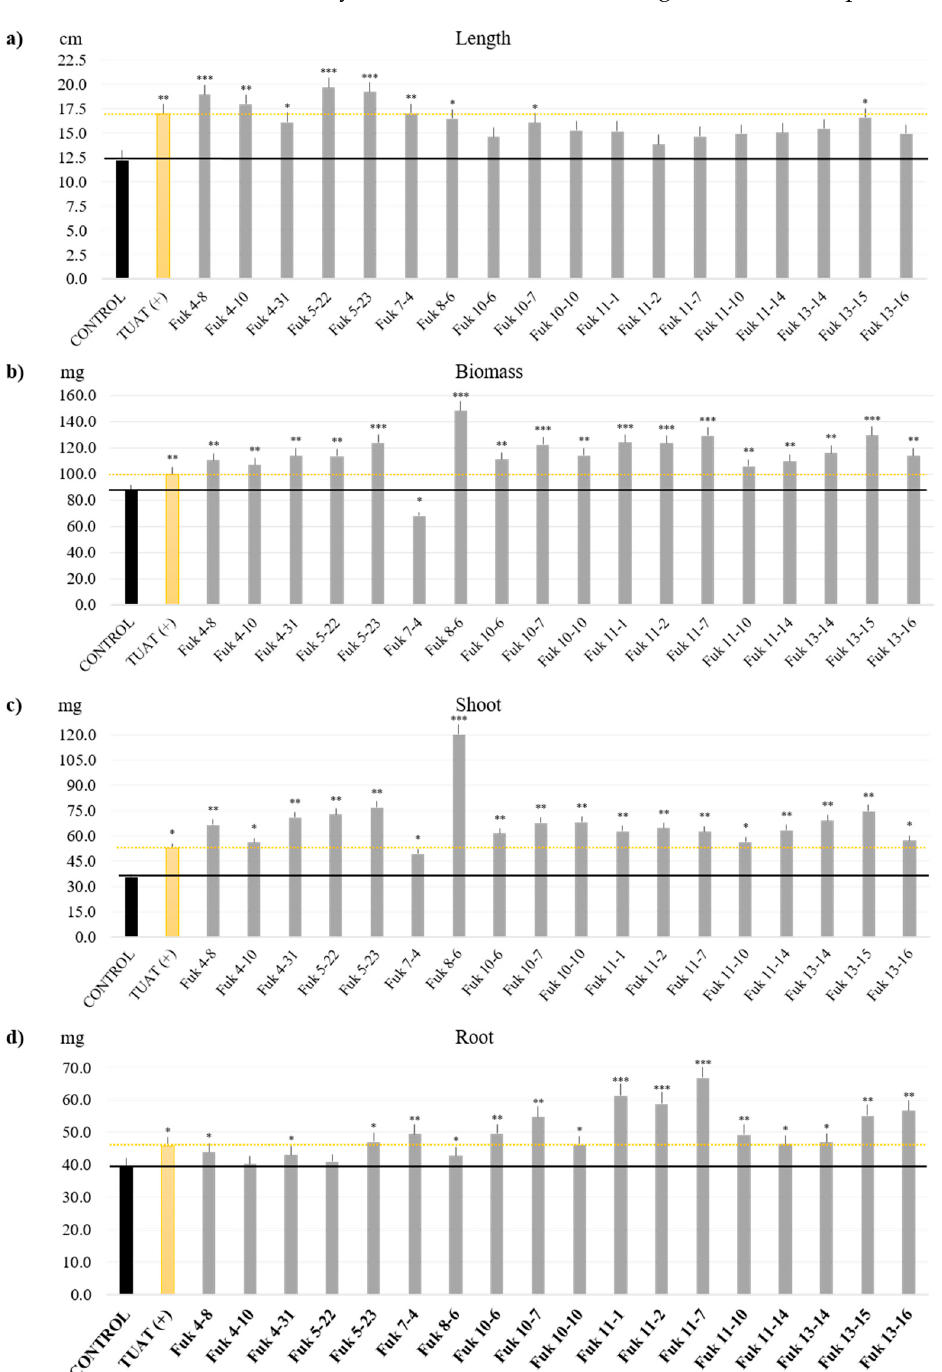
Figure 6. Inoculation of Oryza sativa L. Koshihikai with each pre-selected SF-bacterial isolates. The results are based on the total mass and length average from 5 plants with three replications for each treatment. ( a ) length (cm), ( b ) total fresh biomass (mg), ( c ) total fresh shoot mass (mg), and ( d ) total root mass (mg). Control means non-inoculation, and TUAT1(+) means positive control from based spore-forming biofertilizer. Dunnet’s test was used for length with control as based comparative, and Tukey’s test was applied for other parameters *, **, and *** means a value considered statistical significance with p ≤ 0.05, p ≤ 0.01, and p ≤ 0.001, respectively. No annotation means no significance.